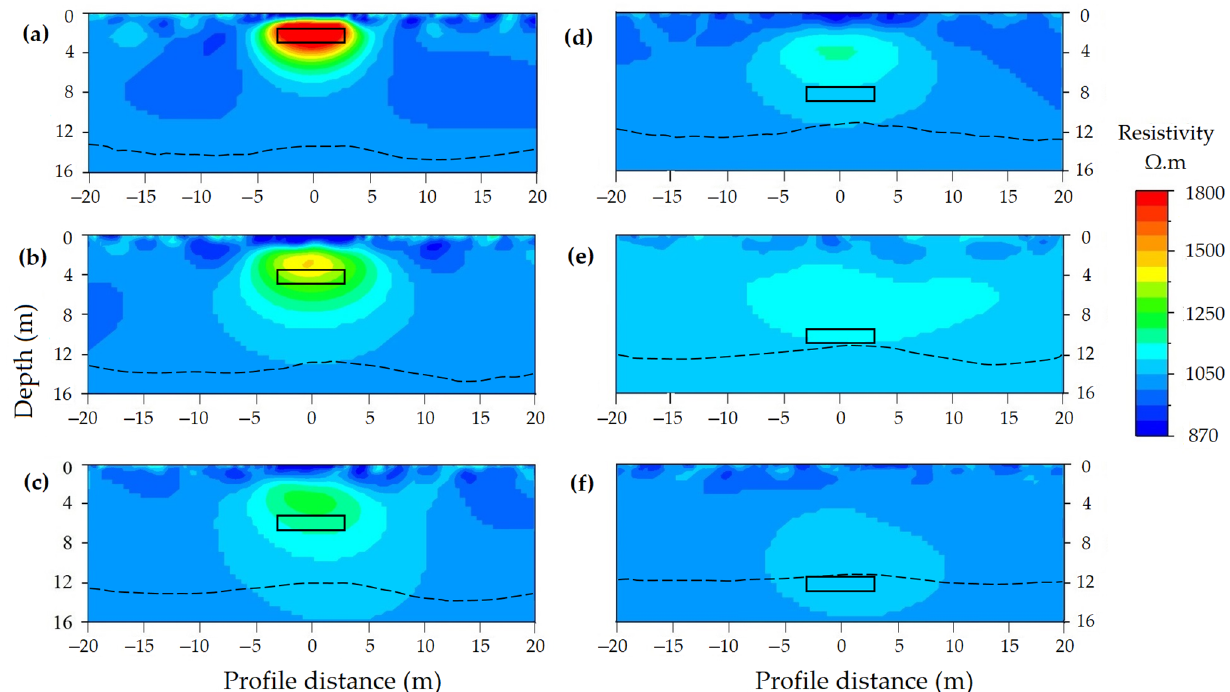
Figure 10. Inverted resistivity model using pole-pole (PP) array for the cavity targets: ( a ) T 1 , ( b ) T 2 , ( c ) T 3 , ( d ) T 4 , ( e ) T 5 , ( f ) T 6 . The rectangular boxes indicate the actual air-filled cavities. The broken lines represent the DOI threshold depths.